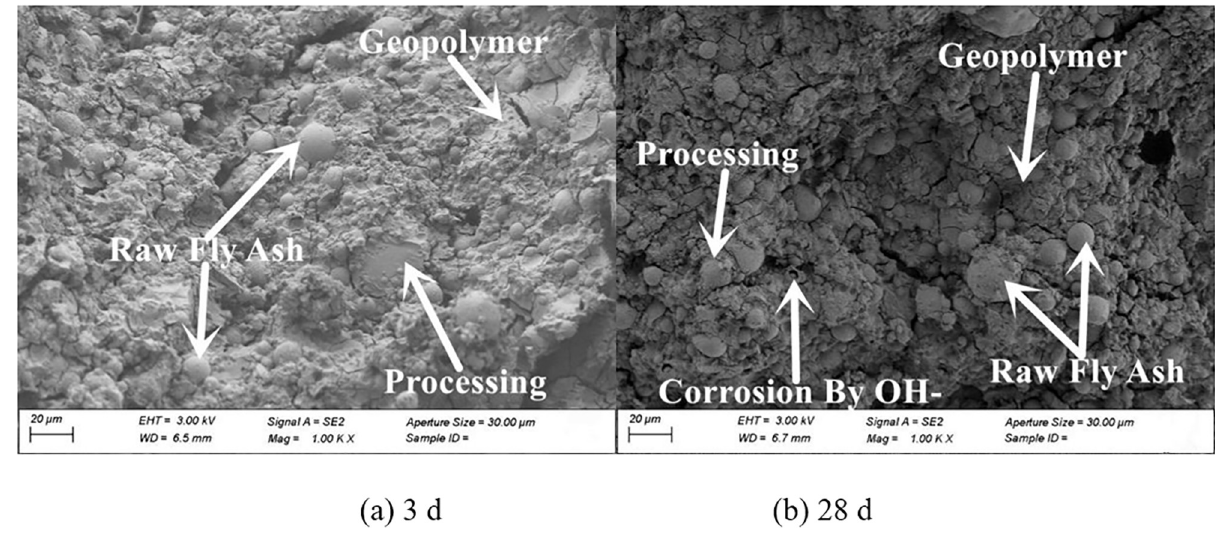
Fig 11. Microscopy analysis of FG0 at 28 d.